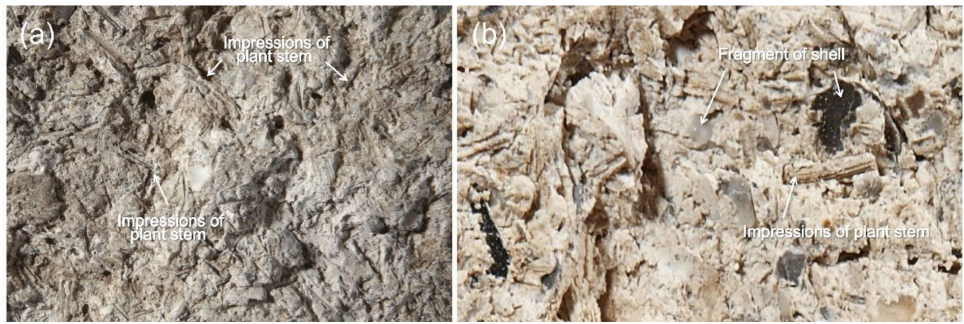
Figure 6. Surface of plaster: ( a ) Image of indentations, presumably caused by the surface of plant stems. ( b ) Image of gray fragments (like shell) mixed in the